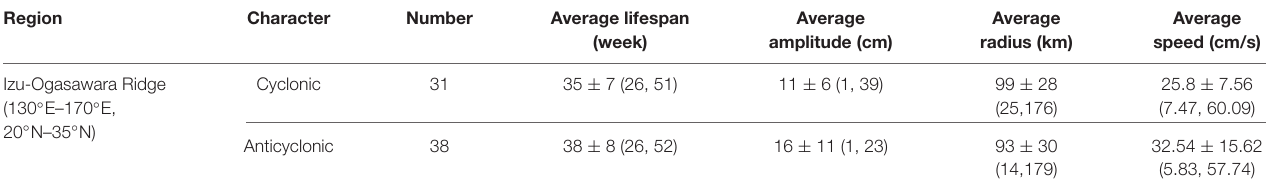
TABLE 2 | Statistics of 69 mesoscale eddies in study from 1993 to 2018. Region Character